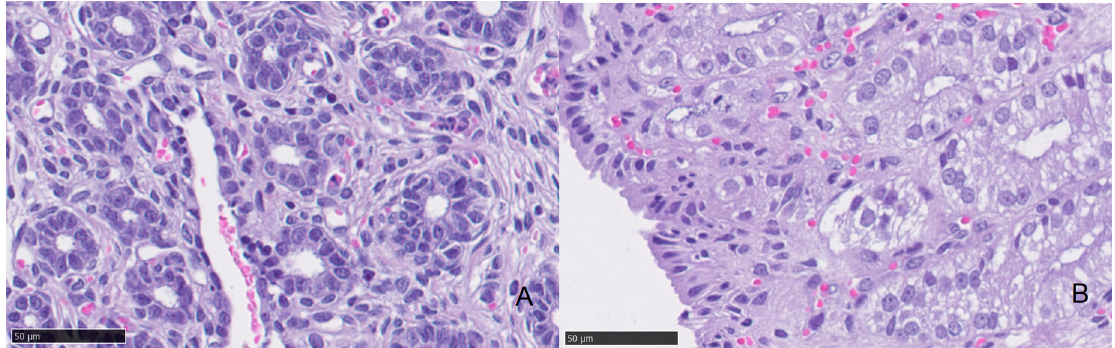
Figure 2. Glandular density in a queen’s endometrium. ( A ) Endometrial biopsy from a queen with low levels of serum progesterone (0.8 ng/mL). ( B ) Endometrial biopsy from a queen with high levels of serum progesterone (7.7 ng/mL). Glandular density scores showed no statistical differences between low and high progesterone groups.